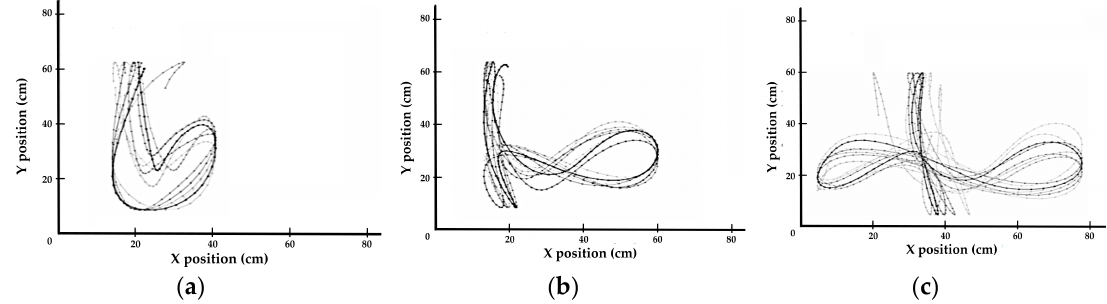
Figure 4. Data points of the continuous gestures captured from tracking users’ palms: ( a ) duple, ( b ) triple, and ( c ) quad.